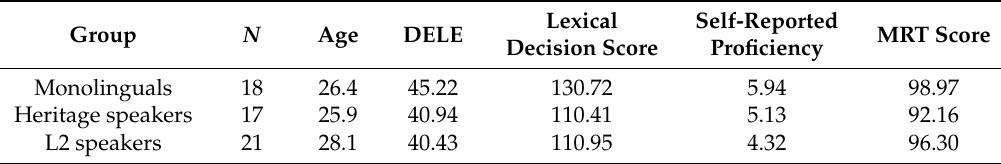
Table 1. Proficiency scores, ages and MRT per